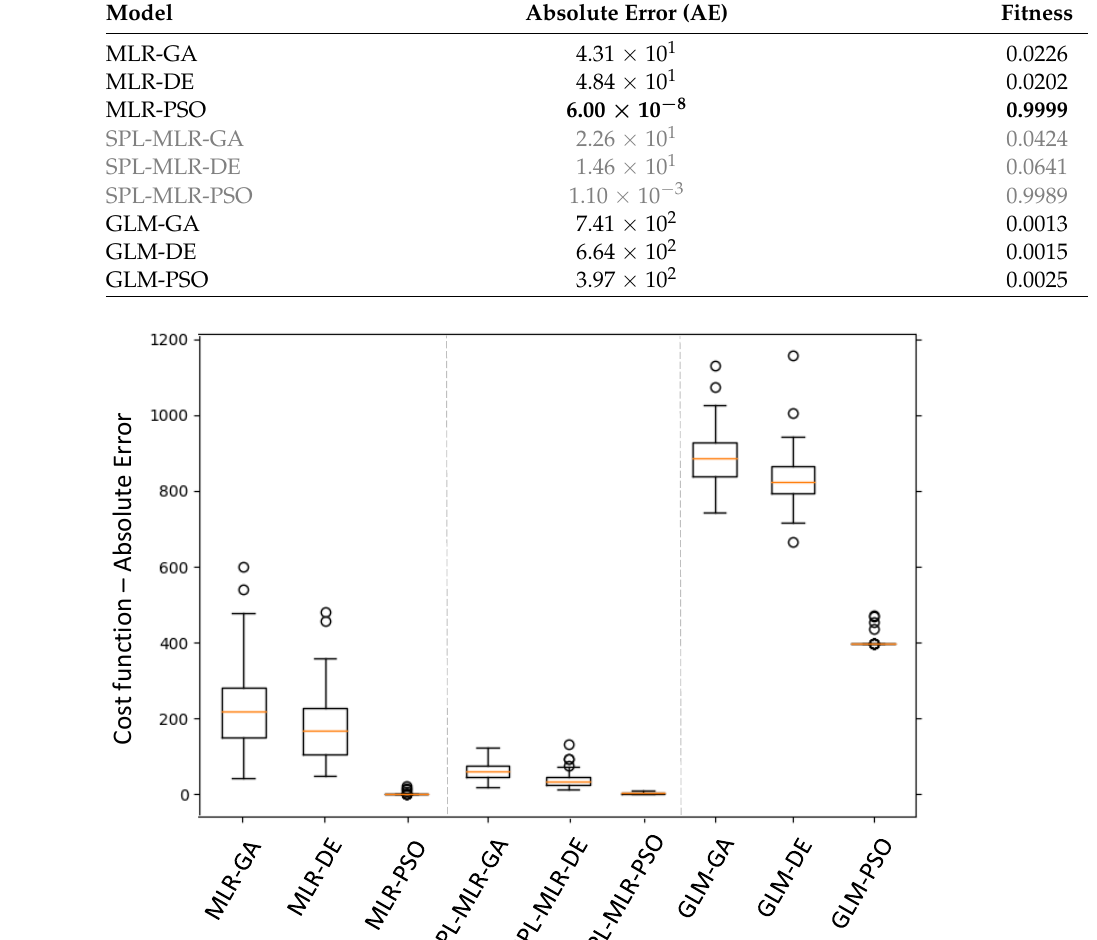
Figure 3. Boxplot for 50 executions of each